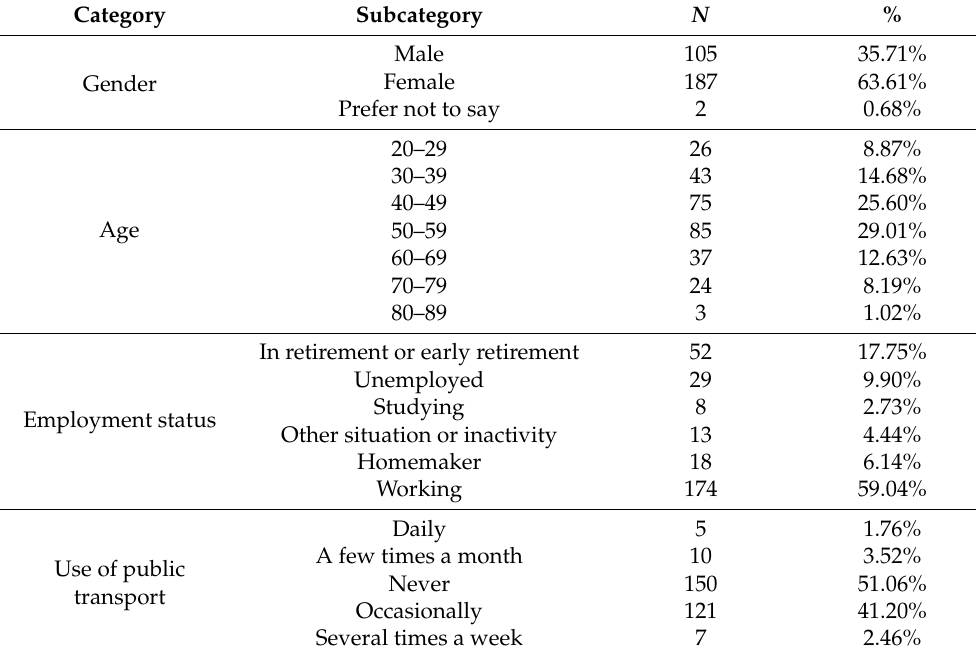
Table 3. Survey sample by